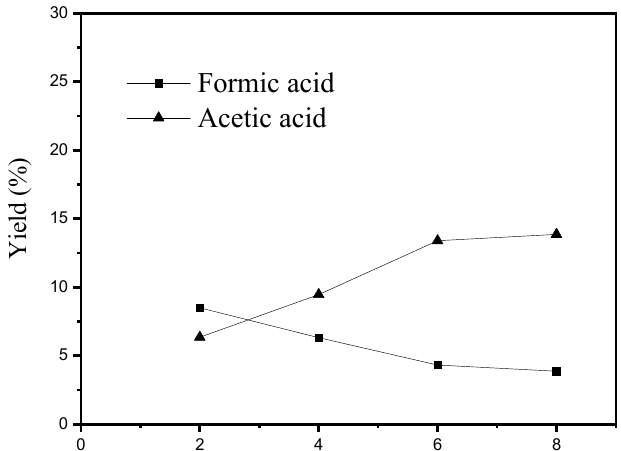
Figure 7. Effects of additional amount of NaOH (guaiacol: 2.65 mmol; 250 °C).